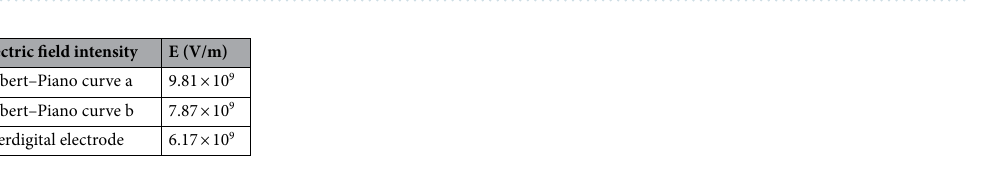
Table 1. Maximum electric field intensity between